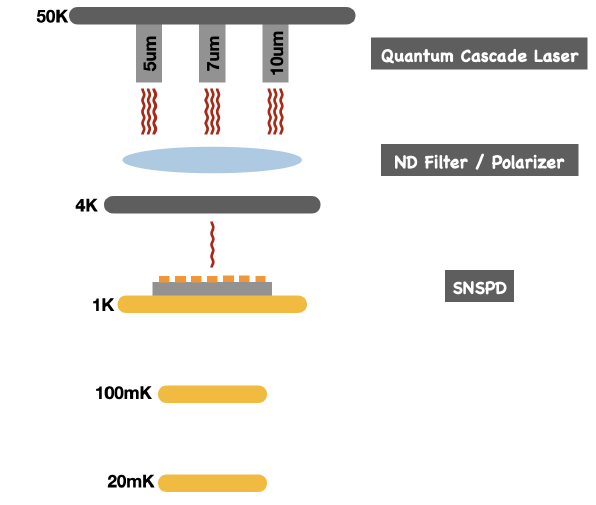
Figure 22. Test-bench setup for testing sensors in open-air transmission by bringing the lasers in the cryostat. In the actual AnaBHEL experiment, the entire experimental chamber would be embedded in a cryogenic system with a high